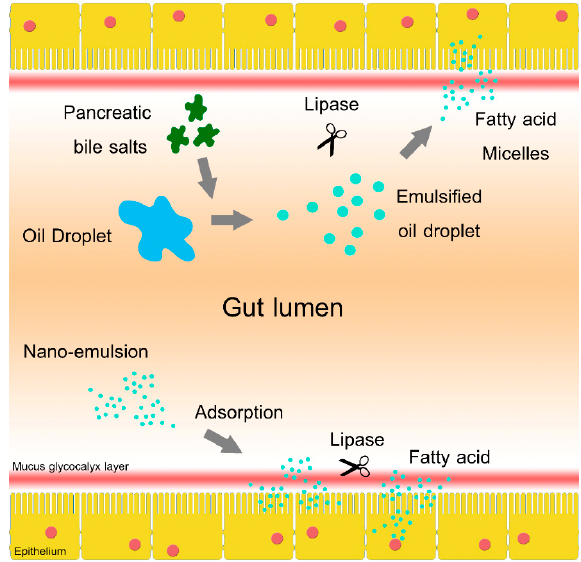
Figure 1. Two different dietary oil/fat absorption mechanisms. The mechanism for conventional dietary oil absorption (upper pathway) consists of emulsification by pancreatic bile salts, digestion with lipase and translocation of fatty acid micelles to the intestinal epithelium. The mechanism for a proposed self-emulsified dietary oil absorption (lower pathway) consist of adsorption of nano-emulsion onto unstirred mucus glycocalyx layer, lipase digestion of the localized oil and the absorption of free fatty acids.